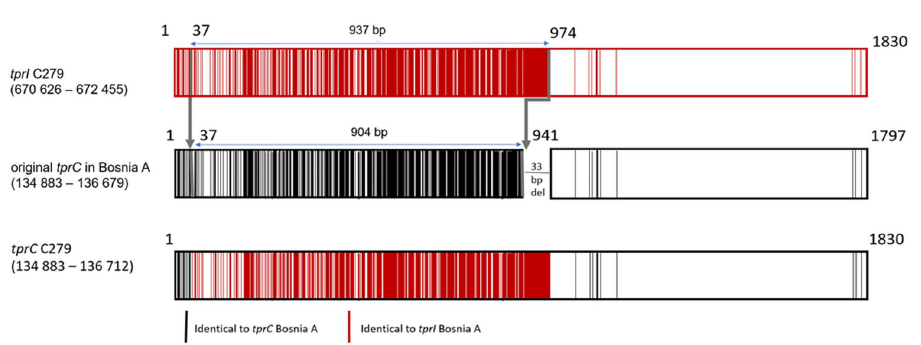
Fig 3. Overview of recombinant tprC in the C279 genome. Recombinant sites within the tprC gene and the resulting tprCI chimera of C279. Black lines represent nucleotides identical to tprC , while red lines nucleotides to tprI . White color represents nucleotides shared between both tprC and tprI genes.